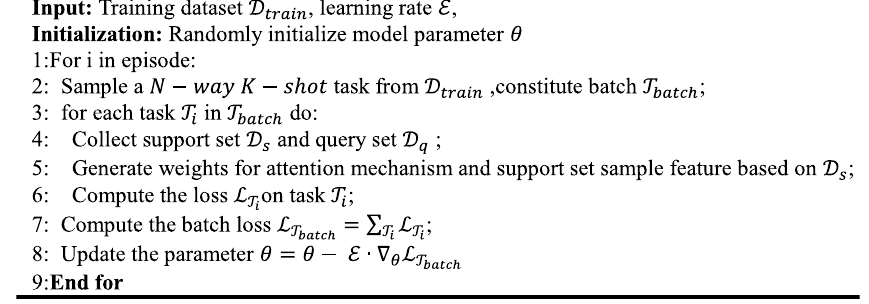
Algorithm 1 Training algorithm of the proposed method for N-way K-shot tasks